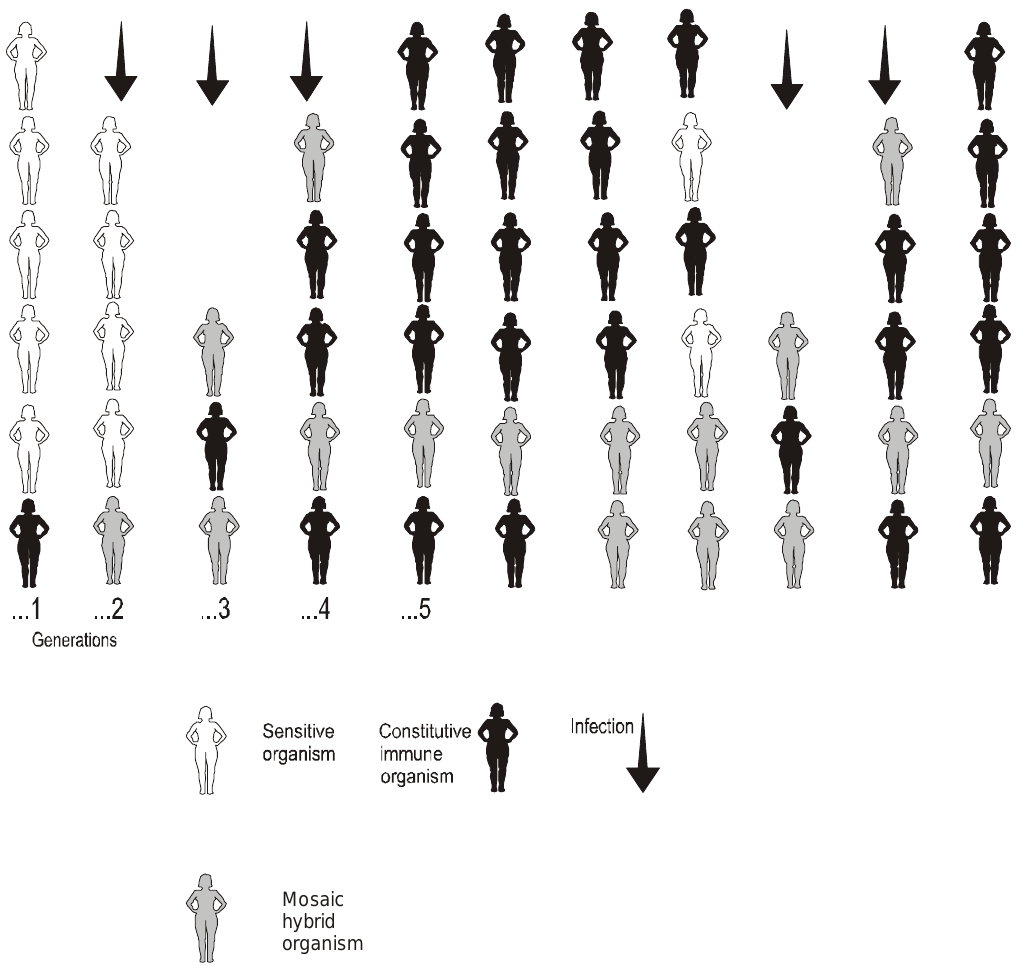
FIGURE 3. Transformation of population in the fight against microbes. a, constitutive immune mutant; b, sensitive organism; c, mosaic hybrid organism. crypt. In contrast, thyroid follicles and breast acini showed a mixture of mono- and polyphenotypia, consistent with a polyclonal origin[34]. Thus, it must not be supposed that all parts of the body are equally liable to specific infectious